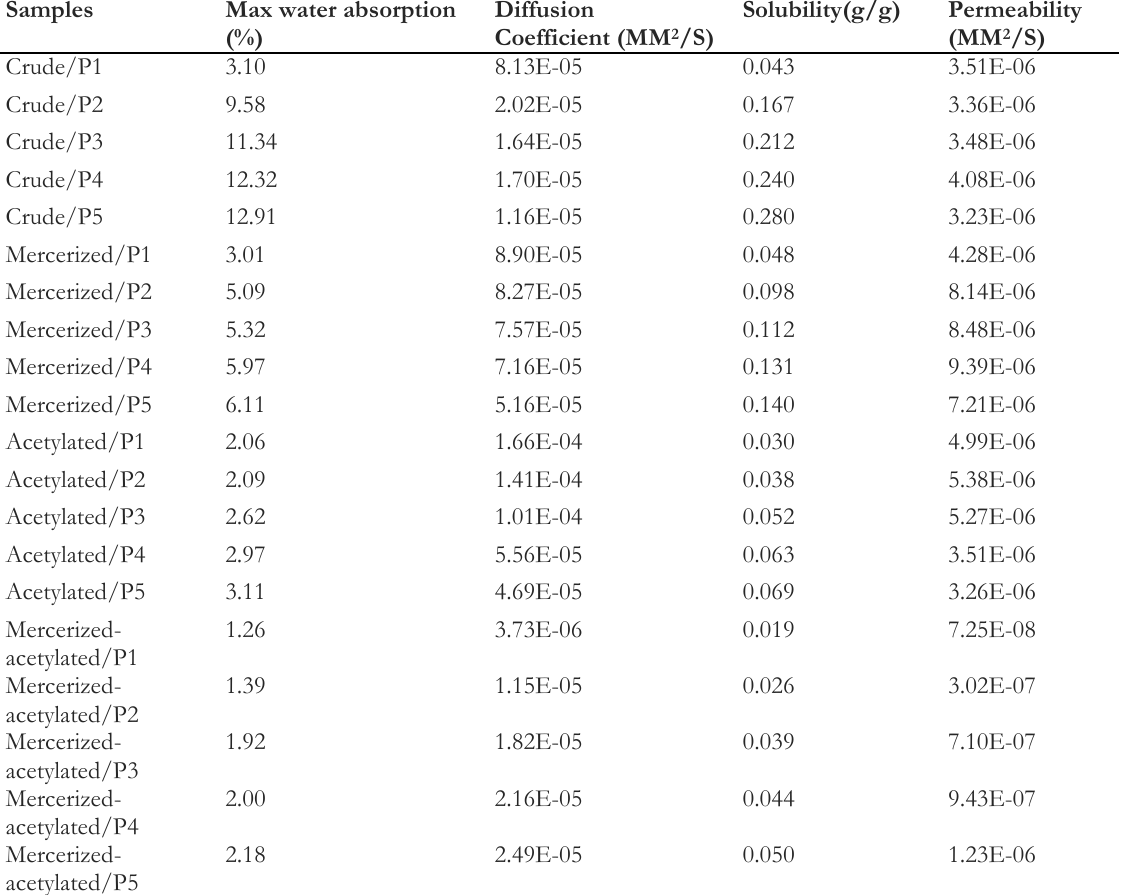
Table 10. Hygroscopic properties of bamboo/polyester composites for various fibre treatments.